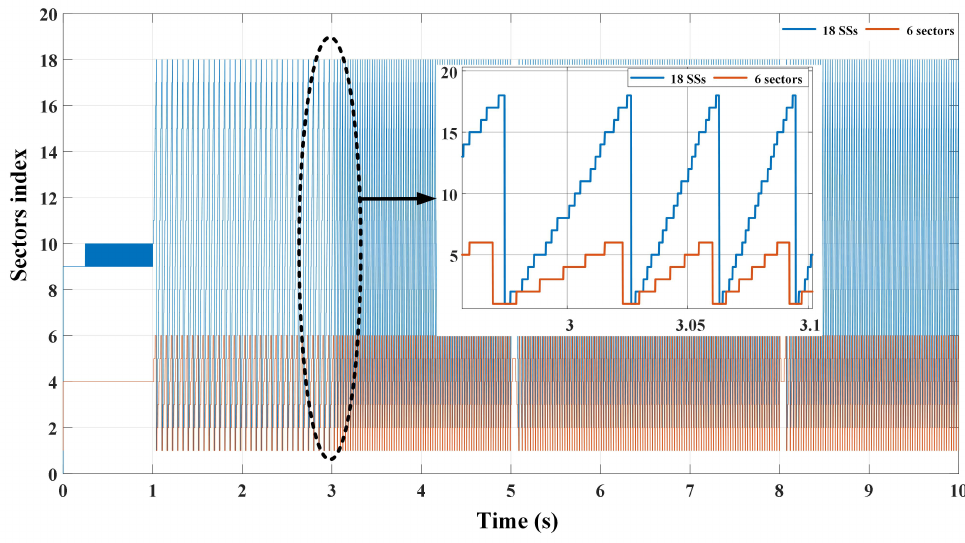
Figure 21. Sectors and sub-sectors of the conventional and improved strategy respectively.